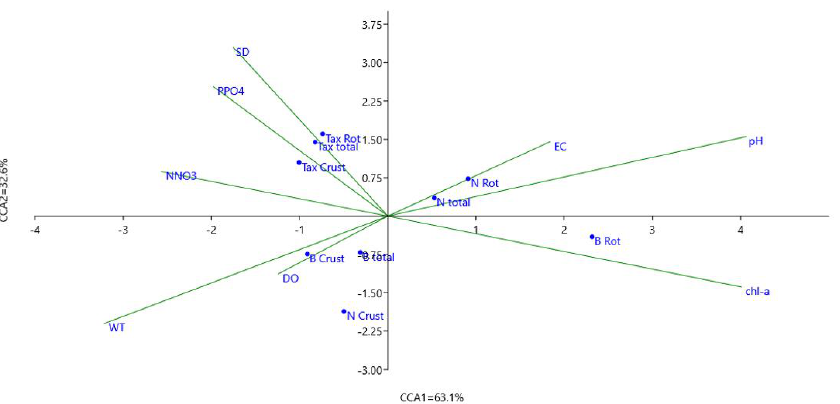
Figure 5. Results of canonical correspondence analysis (CCA) performed on zooplankton and environmental data during vegetation season in the Brda River using forward selection of variables ( p < 0.05). Triplot of significant environmental variables (water temperature: WT, Secchi disk visibility: SD, conductivity: EC, oxygen concentration: DO, pH, chlorophyll: chl- a , nitrate: NNO 3 − , phosphate: PPO 42 – ), number of zooplankton species (Tax total, Tax Rot, Tax Crust), zooplankton density (N total, N Rot, N Crust), and zooplankton biomass (B total, B Rot, B Crust). The triplot at sites of the Bydgoszcz Canal showed that the eigenvalues of the first ( λ CCA1 = 0.655) and second ( λ CCA2 = 0.321) CCA axes accounted for 97.6% of the